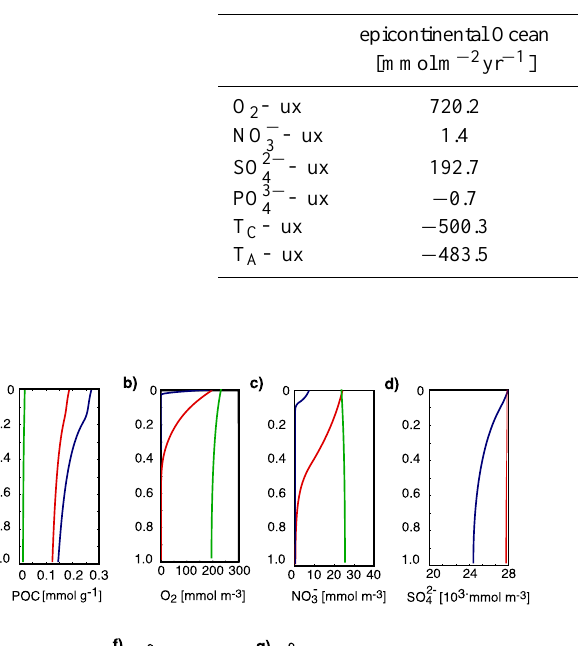
Table 11. Simulated benthic fluxes. A negative sign indicates a flux to the water column, while a positive sign indicates a flux into the sediment.